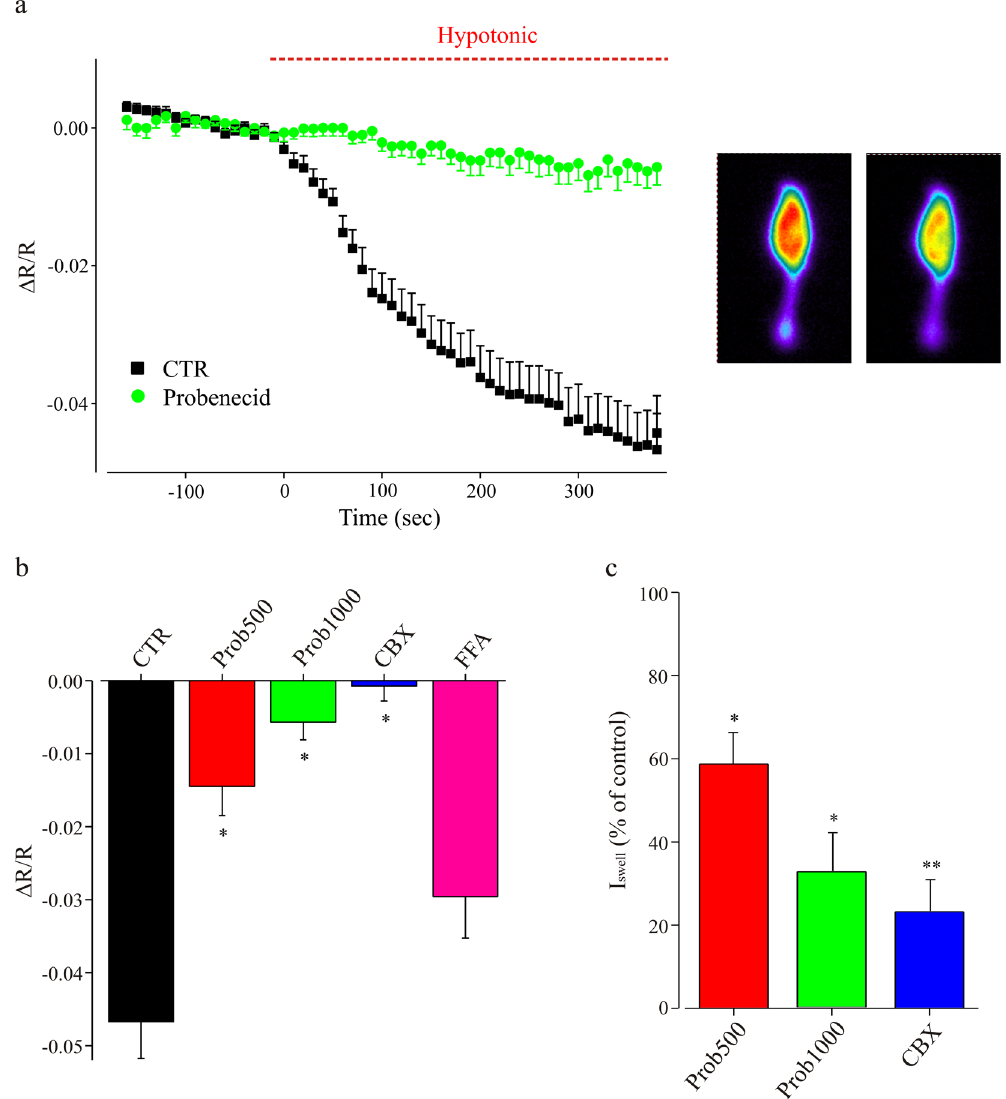
Figure 6. Cell swelling induces ATP release from microglia cells. ( a ) Left, time course of the fluorescence ratio obtained by the acute exposure of BV-2 cells transfected with a FRET-based ATP sensor, to an hypotonic extracellular solution (205 mOsm, red bar) in absence (black; n = 31) or in presence of probenecid (1 mM, green; n = 16; p < 0.05 at 5 minutes of hypotonic medium application); right, representative fluorescence images of a transfected BV2 cell, in normotonic condition (left) and under hypotonic stimulation (right); notice the decrease in fluorescence ratio, indicating a reduction in [ATP] i . ( b ) Bar chart representing the fluorescence ratio evaluated in ATP-sensor transfected BV-2 cells, in response to hypotonic medium (200 mOsm; 5 minutes of application) in the absence of blockers (CTR, black, n = 31) or in presence of probenecid (500 μ M, red, n = 24; 1 mM, green, n = 16) or CBX (100 μ M, blue, n = 13) or FFA (pink, n = 31). * p < 0.05 vs CTR, one-way ANOVA, Holm-Sidak. ( c ) Bar chart showing I Swell in slices treated with probenecid (500 μ M or 1 mM) or CBX (100 μ M), expressed as percentage of the current amplitude in internal controls (recorded in the same experimental days in untreated slices). Probenecid 500 μ M: red; n = 13 vs n = 5; ** p < 0.01, t-test. Probenecid 1 mM: green, n = 9 vs n = 5; ** p < 0.01, t-test. CBX: blue; n = 6 vs n = 4; ** p < 0.01, t-test. I Swell amplitude as in 5c. Statistics were performed on raw amplitude